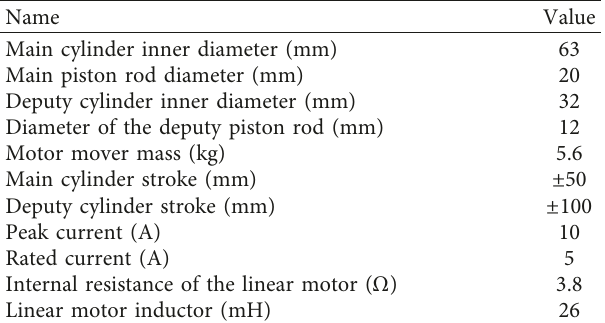
Figure 3: Amplitude-frequency characteristic of the hydraulic electric